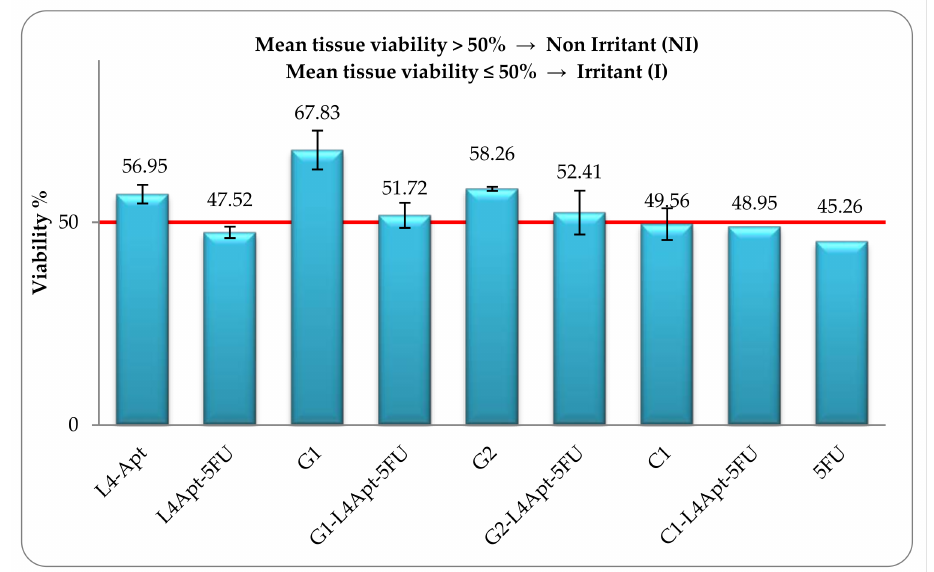
Figure 5. In vitro cell viability in SkinEthic™ RHE tissues treated with different